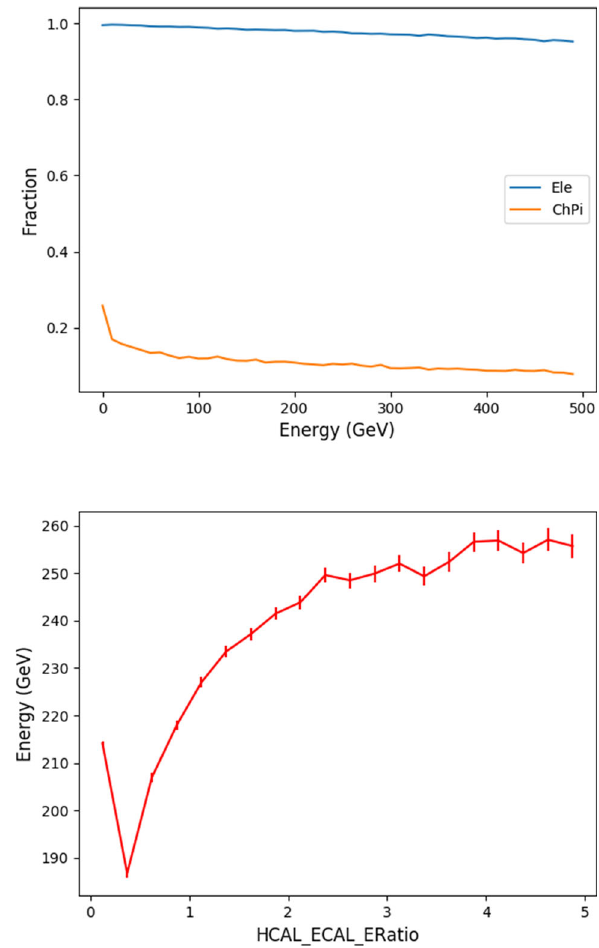
Fig. 3 Fractions of electrons and charged pions that pass a HCAL/ECAL < 0.1 cut at various particle energies (top). Mean charged pion energy as a function of HCAL/ECAL energy ratio (bottom). We see that if a pion makes it into the HCAL, then we tend to see a positive relation between particle energy and the HCAL/ECAL ratio. About 1 out of 5000 events will leave no hits in the calorimeter window at all. These events form the bump in the HCAL/ECAL=0